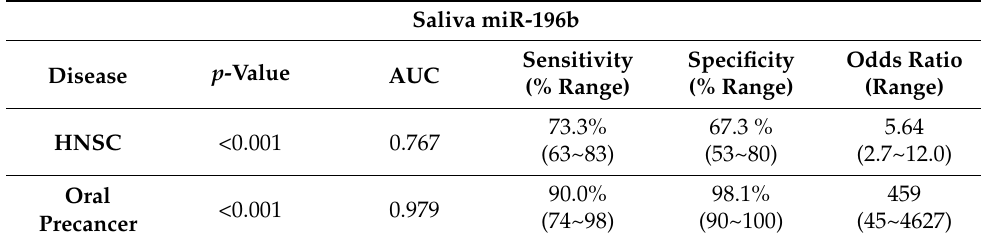
Figure 5. Evaluation of the diagnostic efficacy of miR-196b in the patients with HNSC or OPC. A total of 168 saliva samples from 52 normal individuals, 30 OPC patients, and 86 HNSC patients were recruited. ( A ) Relative expression levels and the significance of miR-196b in differentiation between healthy individuals and HNSC patients. ( B ) Relative expression levels and the significance of miR-196b in differentiation between healthy individuals and OPC patients. The relative expression level with (fold) was presented, after comparison to the level in OECM1 cancer cell lines (1:1000) by RT-qPCR analysis. The horizontal line across the center of the box plot represents the median value. Statistically significant differences were determined using the Mann–Whitney U test. The performance of receiver operating characteristic (ROC) curves and the area under the curve (AUC) of the ROC were shown. Table 2. Diagnostic efficacy for saliva miR-196b levels in patients with HNSC and oral